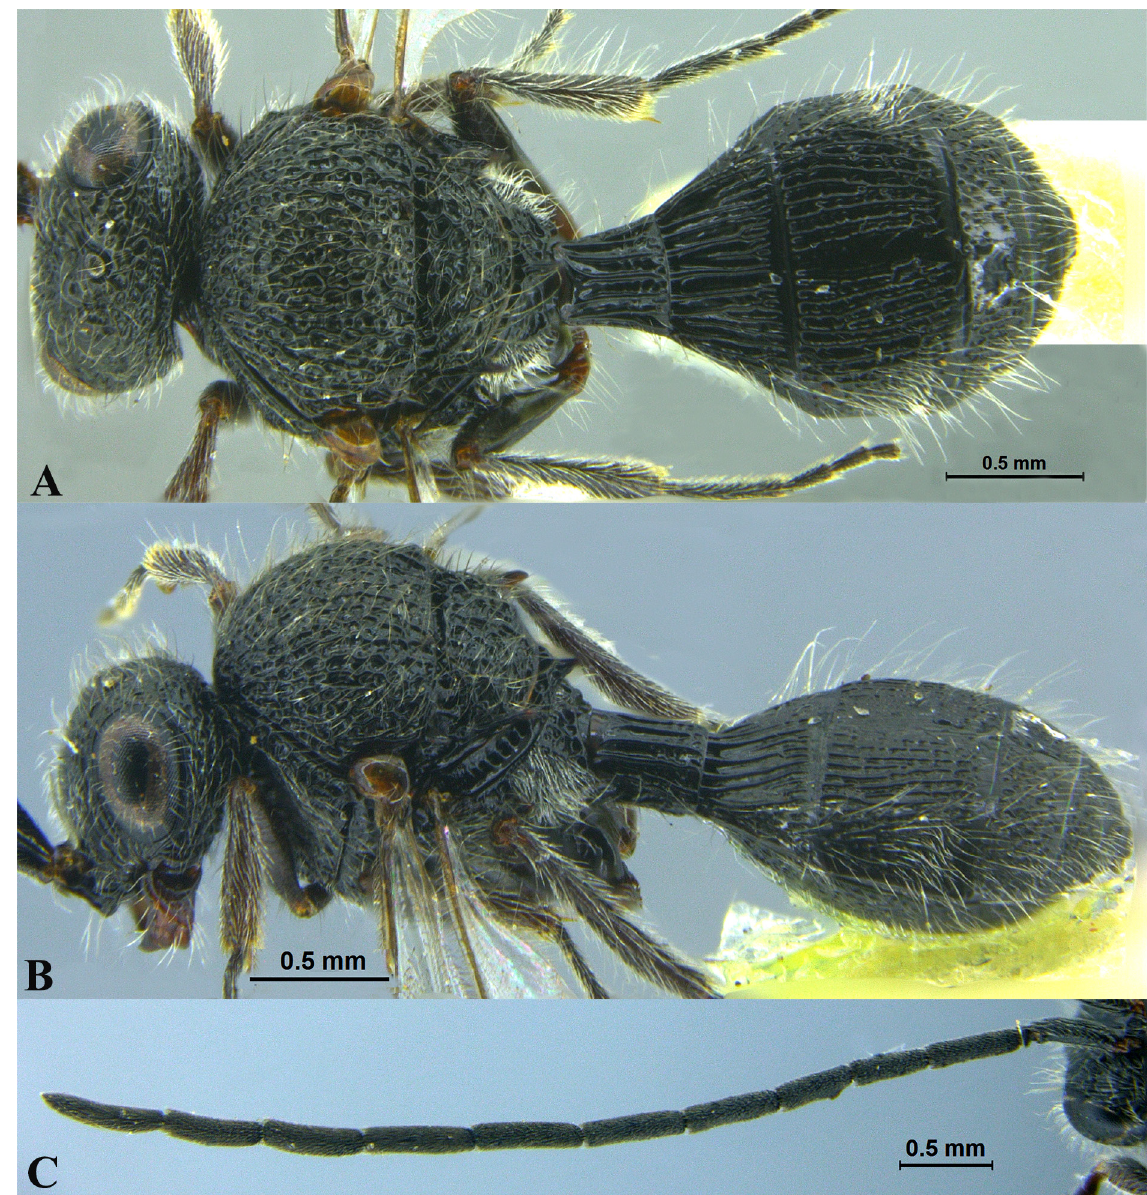
Fig. 19. Odontoscelio vikata Veenakumari & Rajmohana, 2011. Paratype, ♂ (ICAR-NBAII P3). A . Habitus, dorsal view. B . Habitus, showing axillular spines. C .